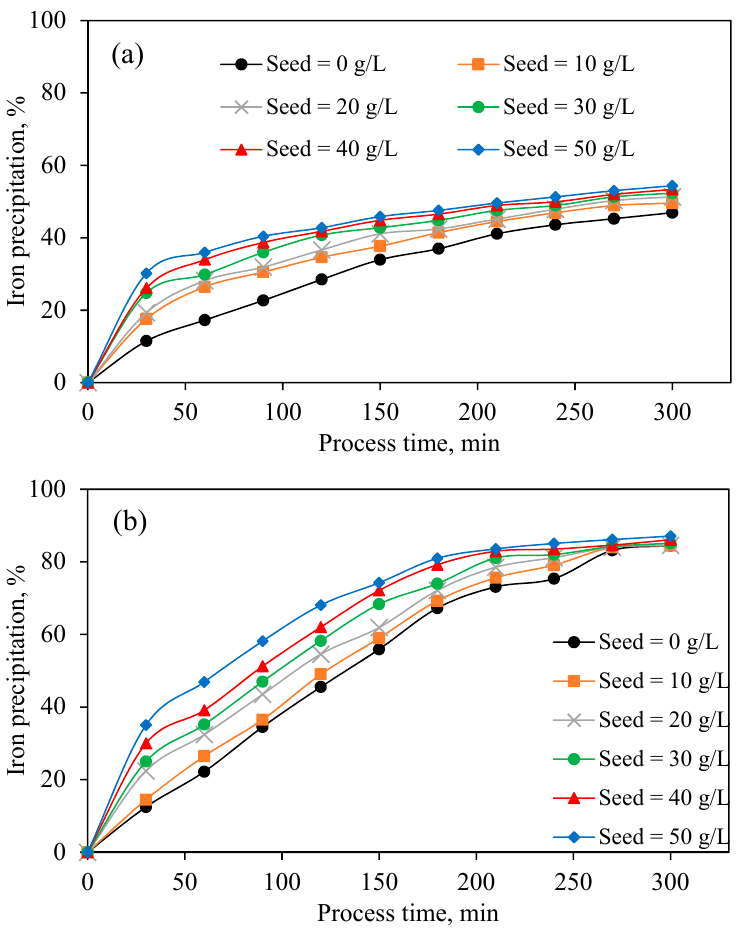
Figure 8. Effect of jarosite seed amount on iron precipitation: ( a ) pH initial = 1, ( b ) Constant pH = 1, (Constant pH = 1, [Na 2 SO 4 ] = 2 g/L, Temperature = 90 °C, Stirring speed = 600 RPM).